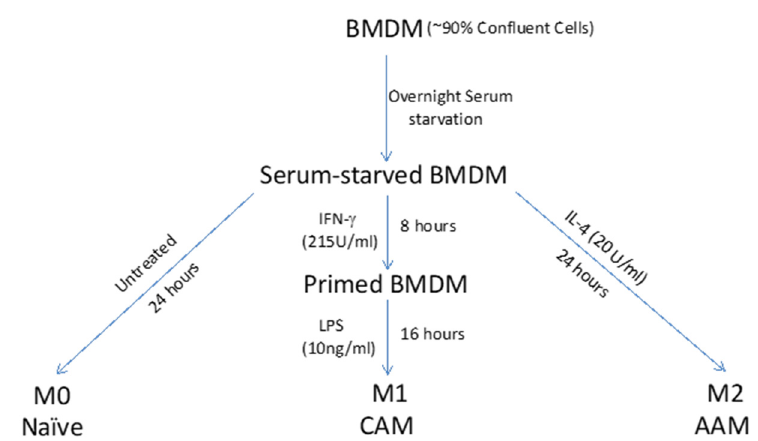
Figure 2. Macrophage